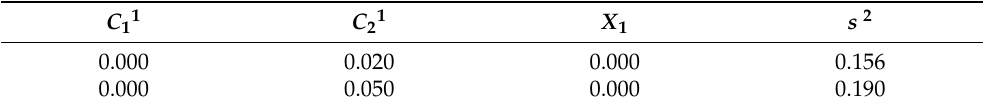
Table 7. Fraction of 5-FU species solubilized by the SDS micelles, s , in 5-FU ( C 1 ) + SDS ( C 2 ) aqueous solutions at T = 298.15 K and P = 101.3